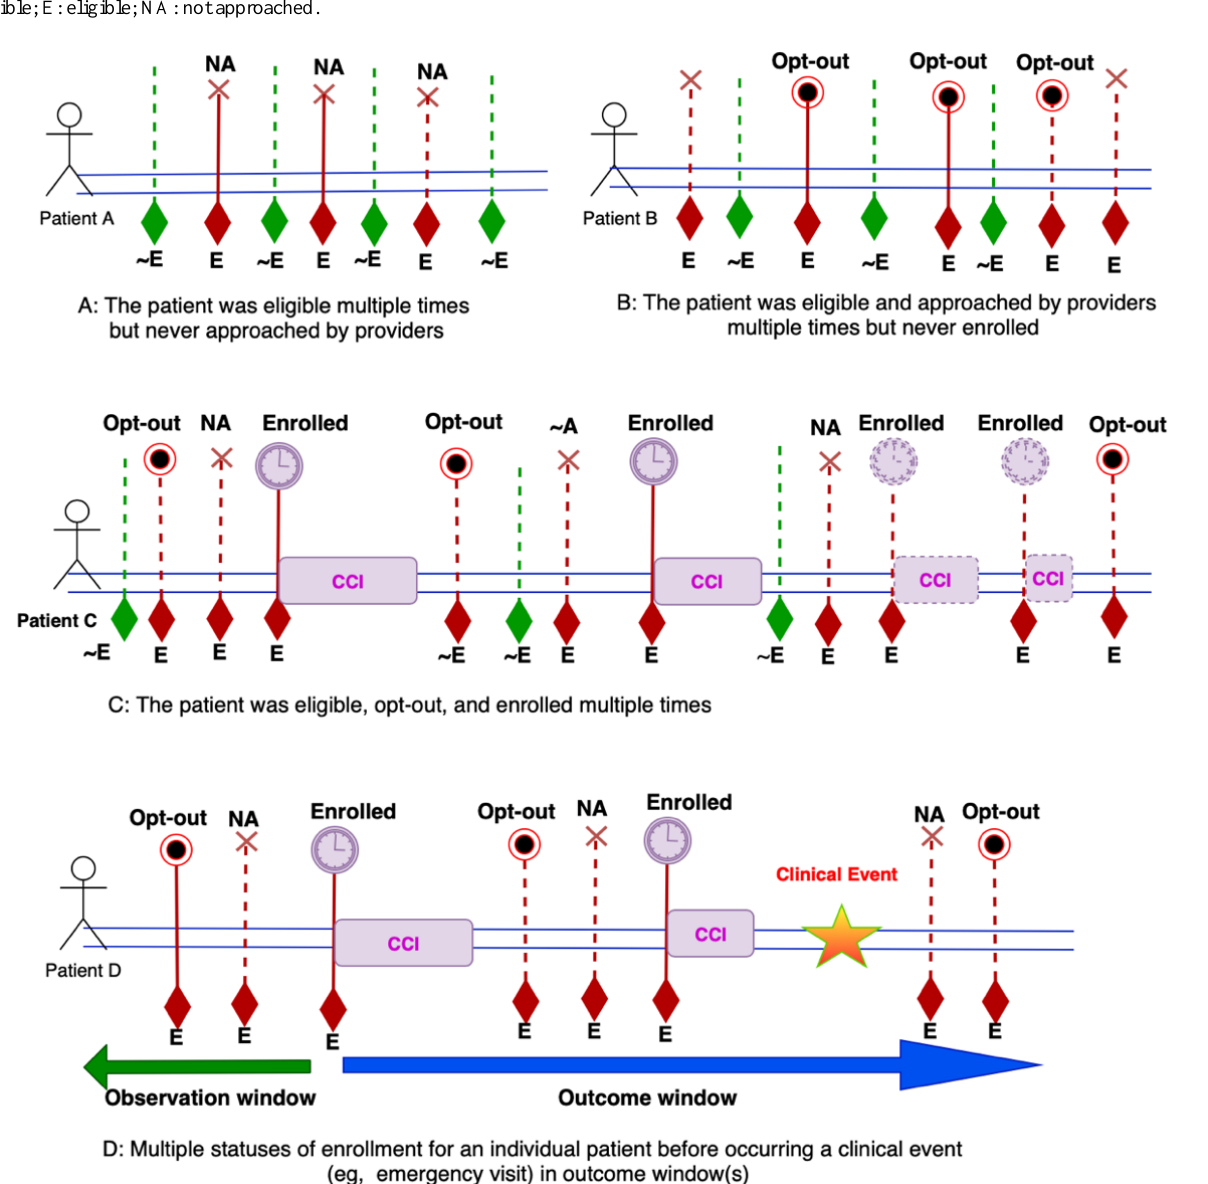
Figure 3. An illustration of a patient with multiple statuses in the Integrated Behavioral Health registry. CCI: care coordination intervention; ~E: not eligible; E: eligible; NA: not